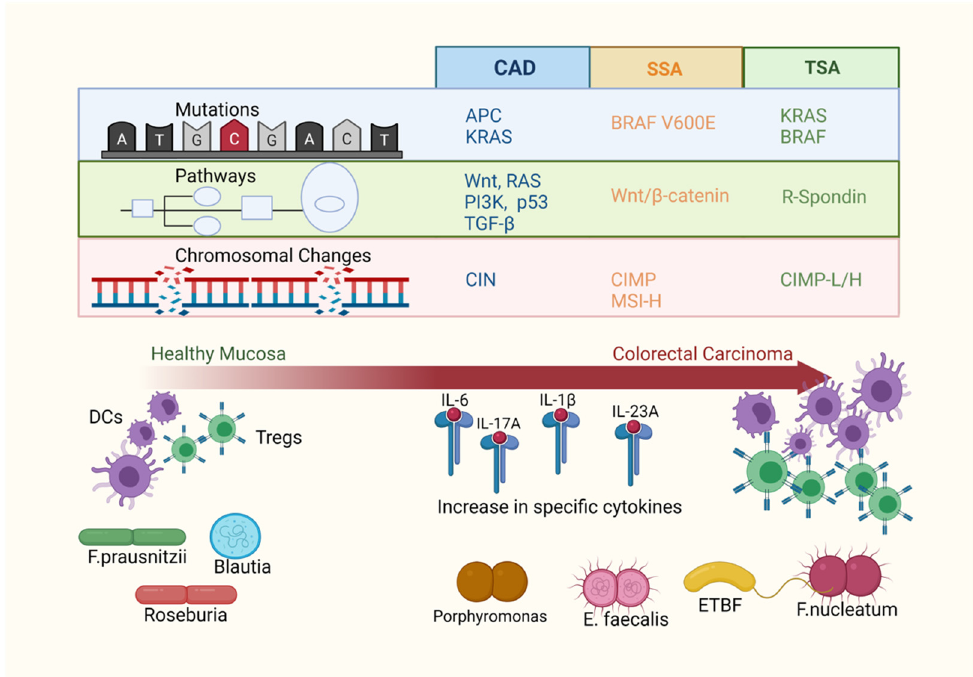
Figure 1. The progression of colorectal polyps to adenocarcinoma is multi-factorial, with different polyp subtypes showing patterns in their genetic, immune and microbiome features. Genetic environment: conventional adenomas (CAD) are characterised by chromosomal instability (CIN) and show early mutations in the adenomatous polyposis coli ( APC ) and KRAS genes, with dysregulated Wnt, RAS, PI3K, p53 and TGF- β intracellular pathways. Commonly driven by BRAF V600E mutation and with disruptions in Wnt/ β -catenin signalling pathways, serrated sessile adenomas (SSAs) show aberrant methylation, (CIMP+) and can be MSI-high or MSS. Traditional serrated adenomas (TSAs) can have either BRAF or KRAS mutations, RNF43 inactivation and often show R-spondin gene fusions. They may be either CIMP-low or CIMP-high. Immune environment: progression from polyps to carcinoma is correlated with a decrease in the ratio of mature dendritic cells to immature dendritic cells (DCs), as well as an increase in the relative number of regulatory T cells (Tregs). Increases in pro-inflammatory cytokines such as IL-6, IL-17A, IL-1 β and IL-23A are reported. Microbiome environment: relative to healthy tissue, mucosal polyps and carcinoma have altered microbial communities such as decreases in F. prausnitzii, Roseburia and Blautia , and an increased relative abundance of bacteria including enterotoxic Bacteroides fragilis (ETBF), E. faecalis and F. nucleatum